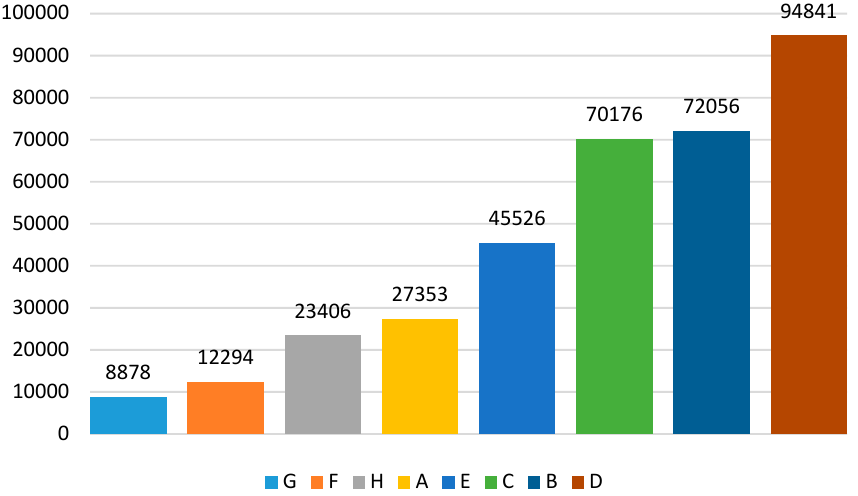
Figure 15. Increasingly ordered values of the ontogenetic matrix determinants calculated for the particular analysed RTEs (A–H).